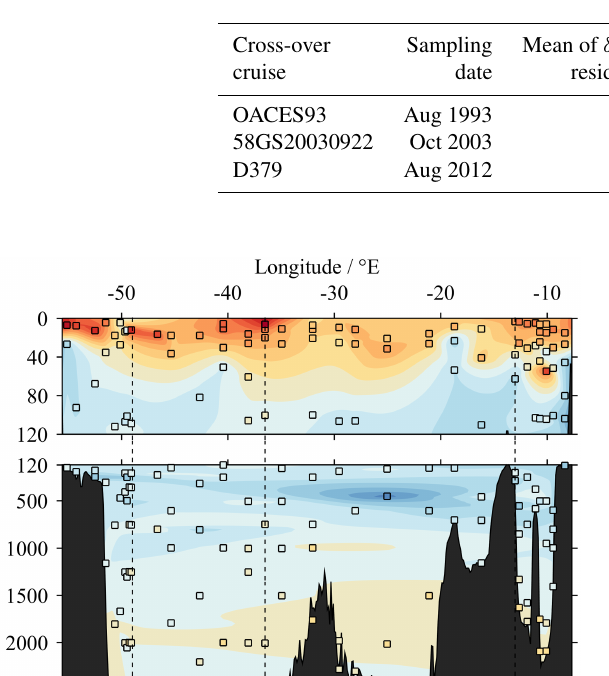
Table 2. Results of the cross-over analysis. Sources: OACES93 on R/V Malcolm Baldrige , carbon PIs F. Millero, R. Feely and P. Quay, data from Schmittner et al. (2013); 58GS20030922 on G. O. Sars , carbon PIs A. Olsen and T. Johannessen, data from Schmittner et al. (2013);